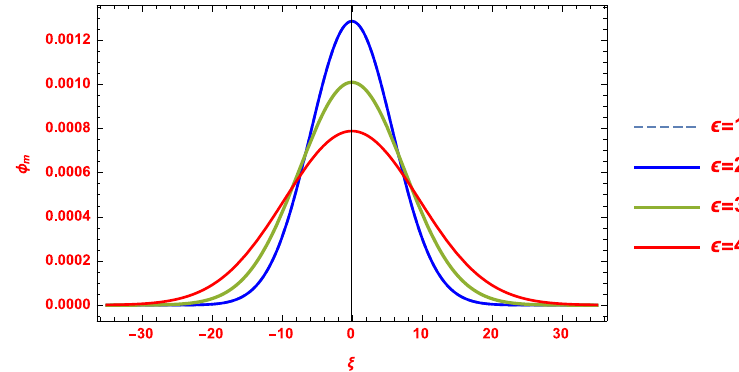
Figure 7. φ m varying along ξ for different We .